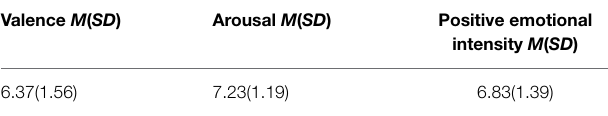
TABLE 3 | Evaluation results for video